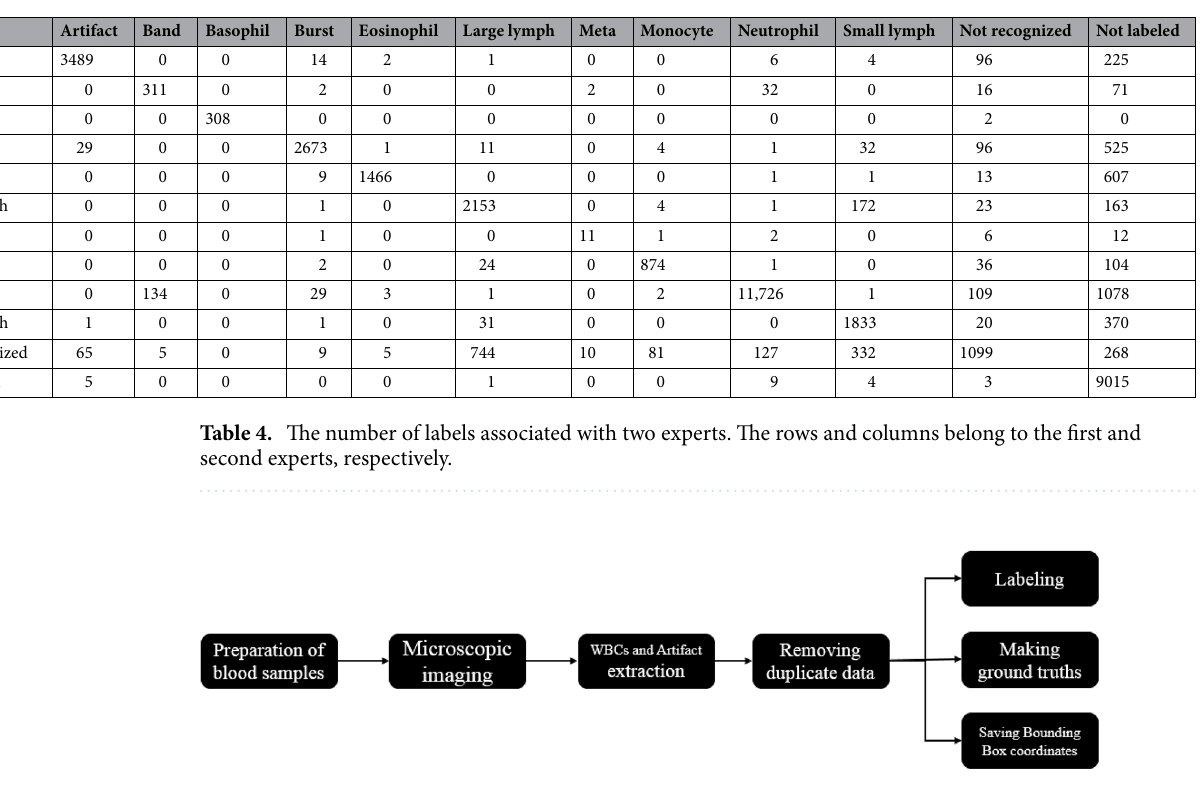
Figure 3. Main steps of the Raabin-WBC dataset